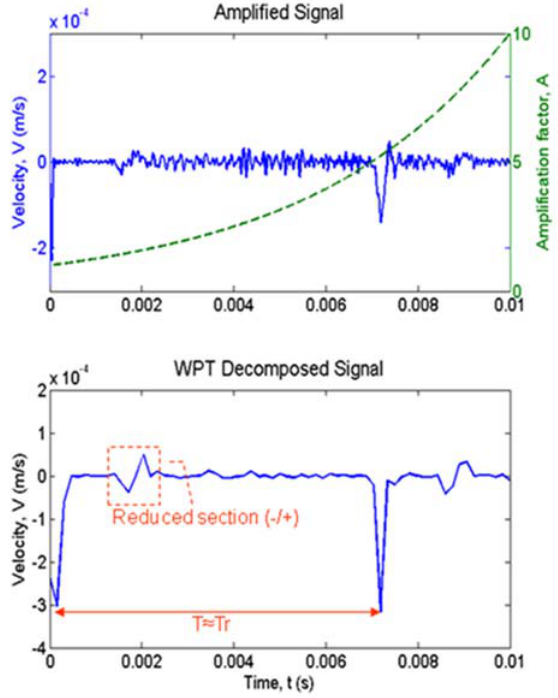
Figure 14. Amplified and WPT decomposed velocity signal for case d of dataset 4 (neck